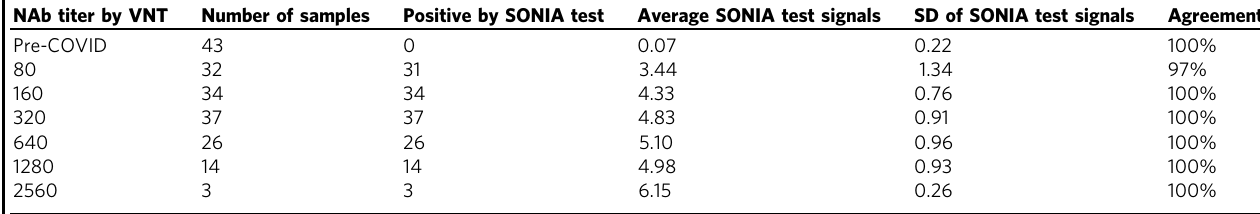
Patient specimens were tested by SONIA and viral neutralization test (VNT). The concordance between the two methods was